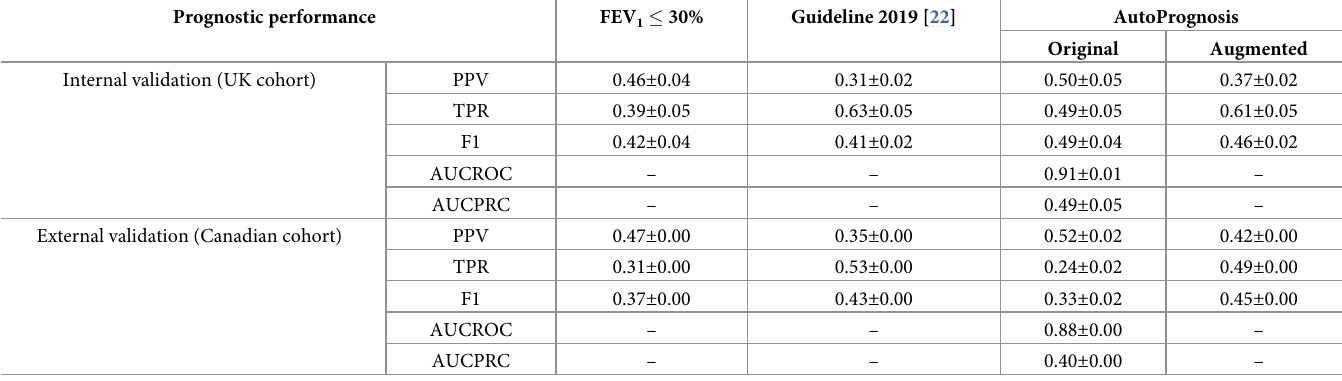
Table 3. Diagnostic performance of four LTx referral policies. The policy of FEV 1 � 30% predicted and a FEV 1 -based policy derived from a 2019 guideline were used as two baselines. Apart from the original AutoPrognosis policy developed on the studied UK CF cohort, an augmented AutoPrognosis policy with two additional criteria developed from the Canadian CF data was included in the evaluation as well. As a balanced measurement of prognostic accuracy, a high F1 score comes with high PPV and TPR scores. Decrease in either PPV or TPR score leads to a lower F1 score. Desirable LTx referral policies ought to have a high F1 score. All evaluation results were reported with 95%